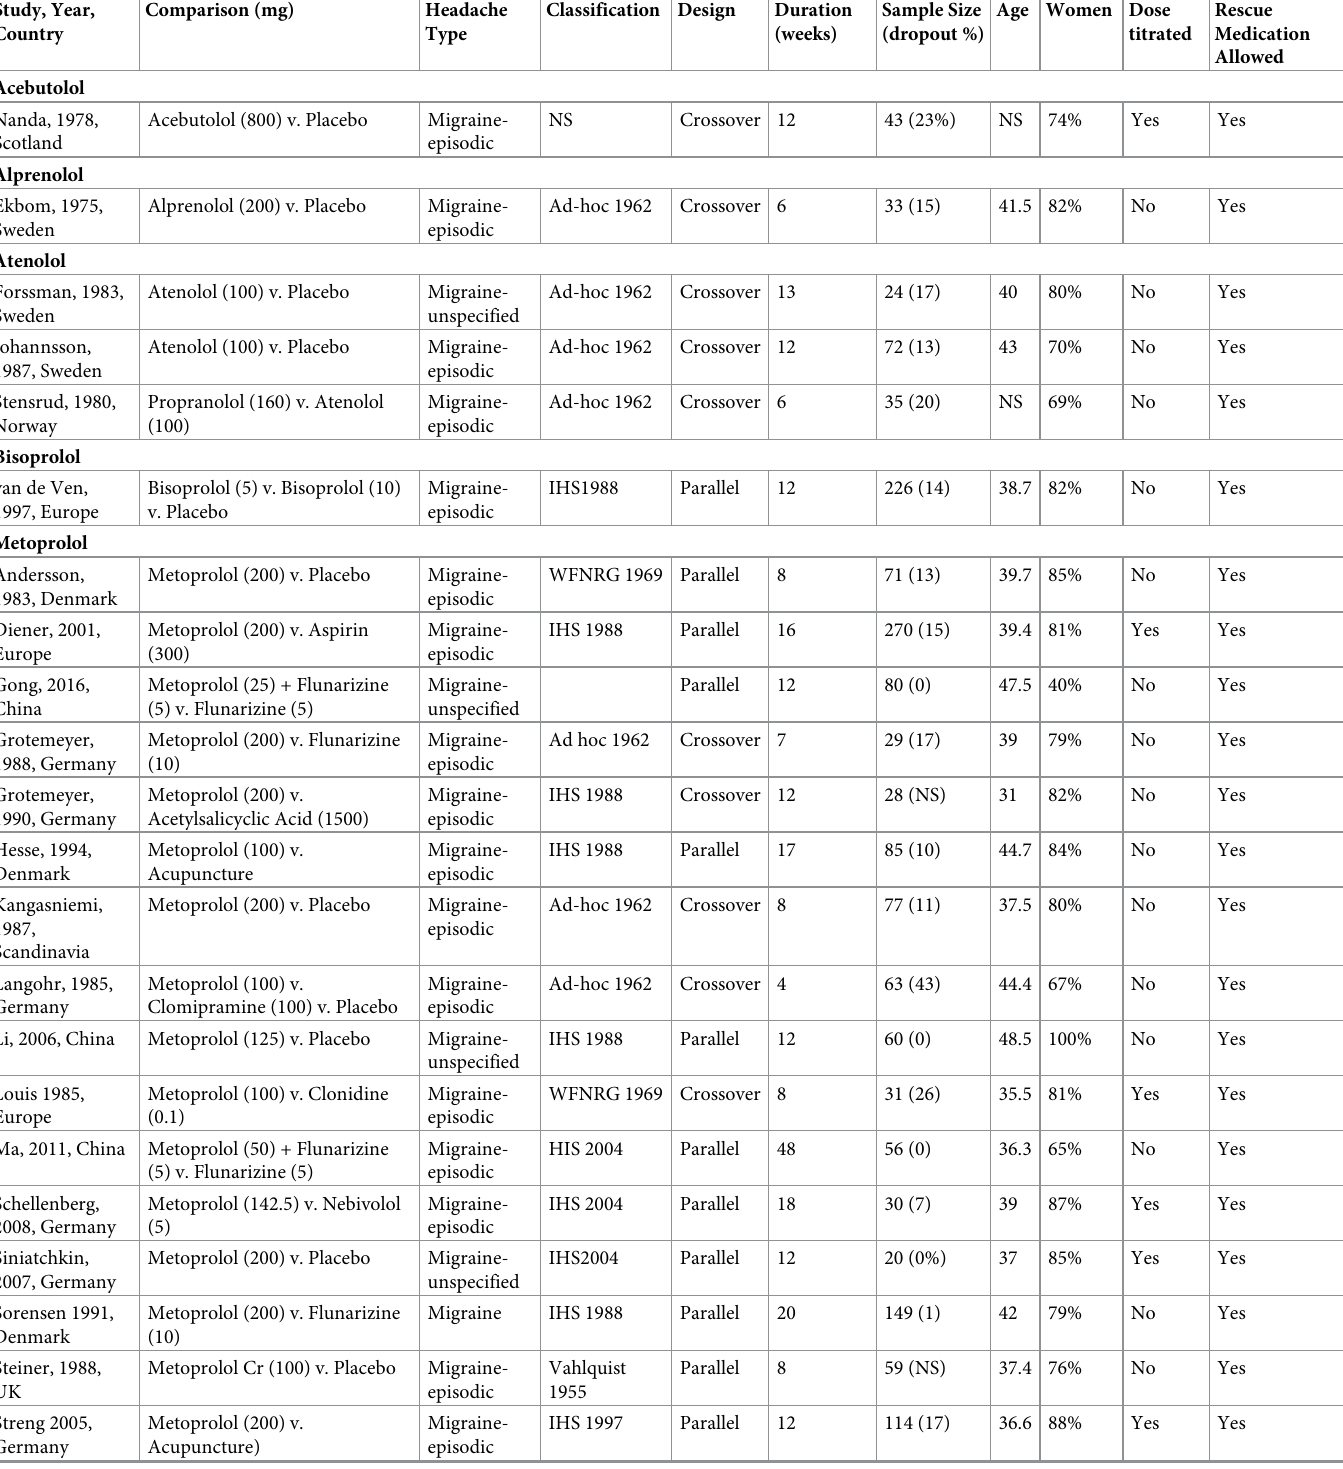
Table 1. Included trial